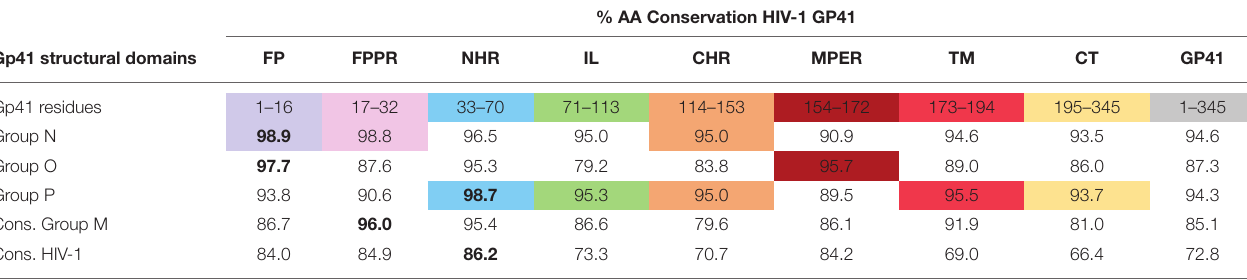
TABLE 3 | Percentage of aa conservation in each gp41 structural domain across HIV-1 groups and HIV-1 consensus